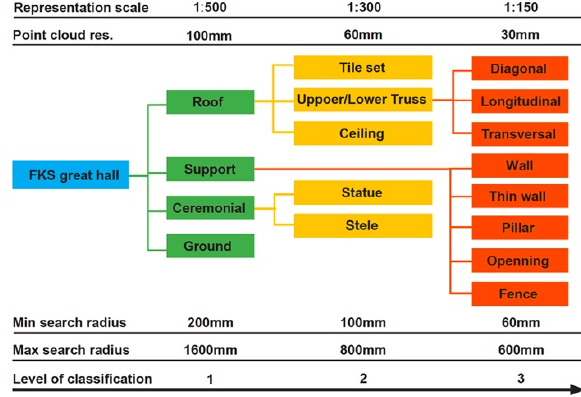
Figure 7. Classes of the point cloud for FKS project.